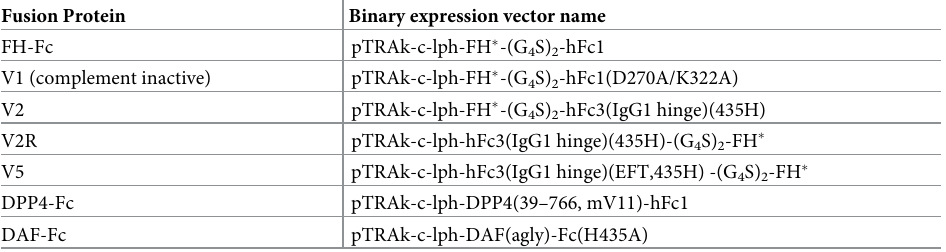
Table 1. Description of plant-produced FH � -Fc